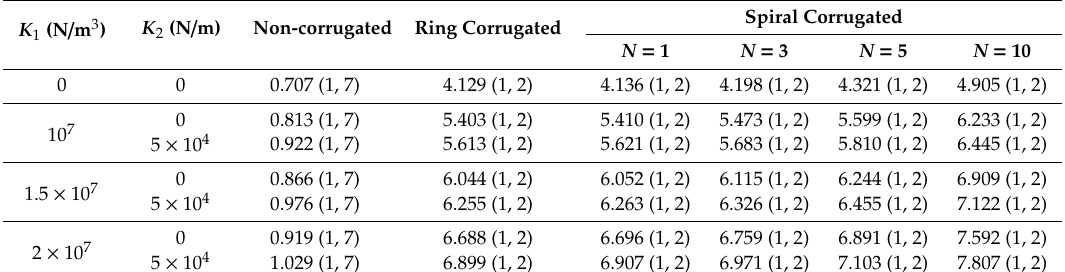
Table 6. The critical buckling pressure of round corrugated sandwich FGM cylindrical shells with di ff erent values of elastic foundation moduli (MPa) ( r = 0.015 m , d = 0.005 m , k = 1).